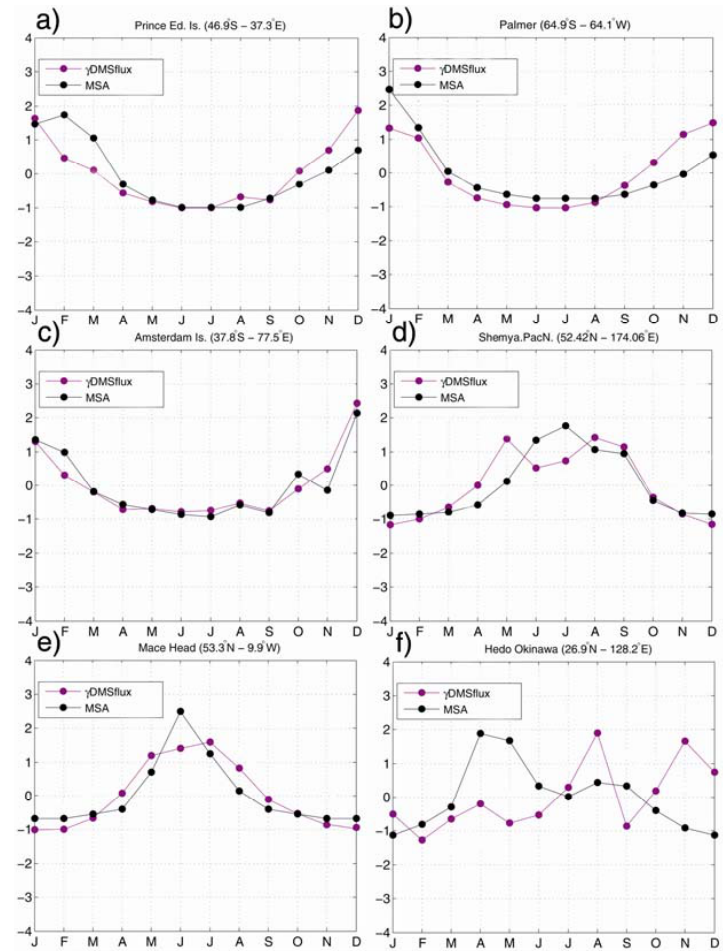
Fig. 4. Validation of the biogenic sulfur aerosol parameterization. Seasonal evolution of standardized values of computed γ DMSflux Figure 4